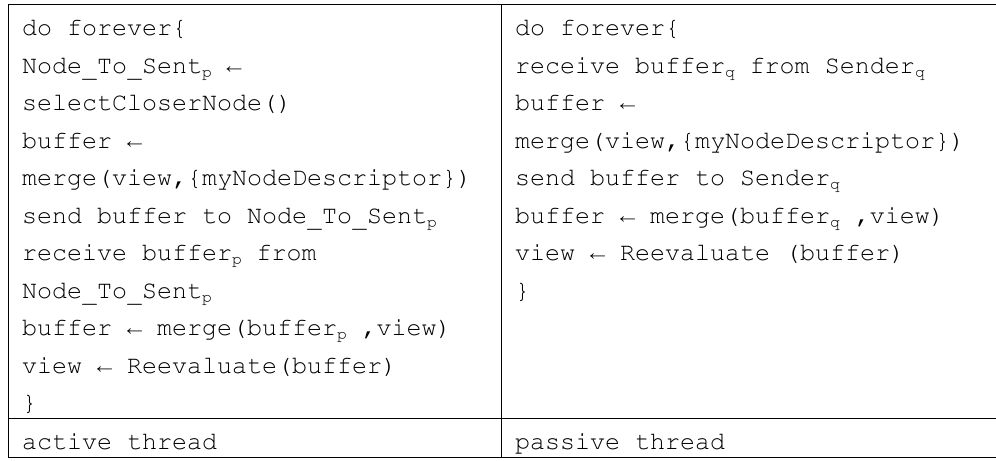
Table 2. T-MAN pseudo